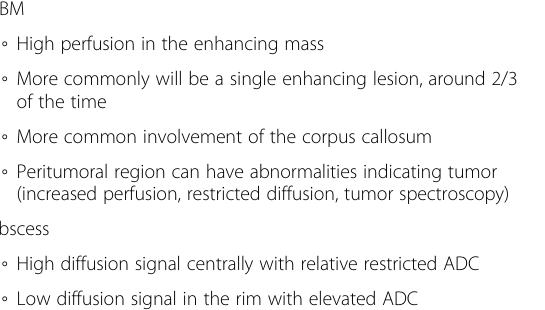
Table 2 How to differentiate CNS PTLD from other